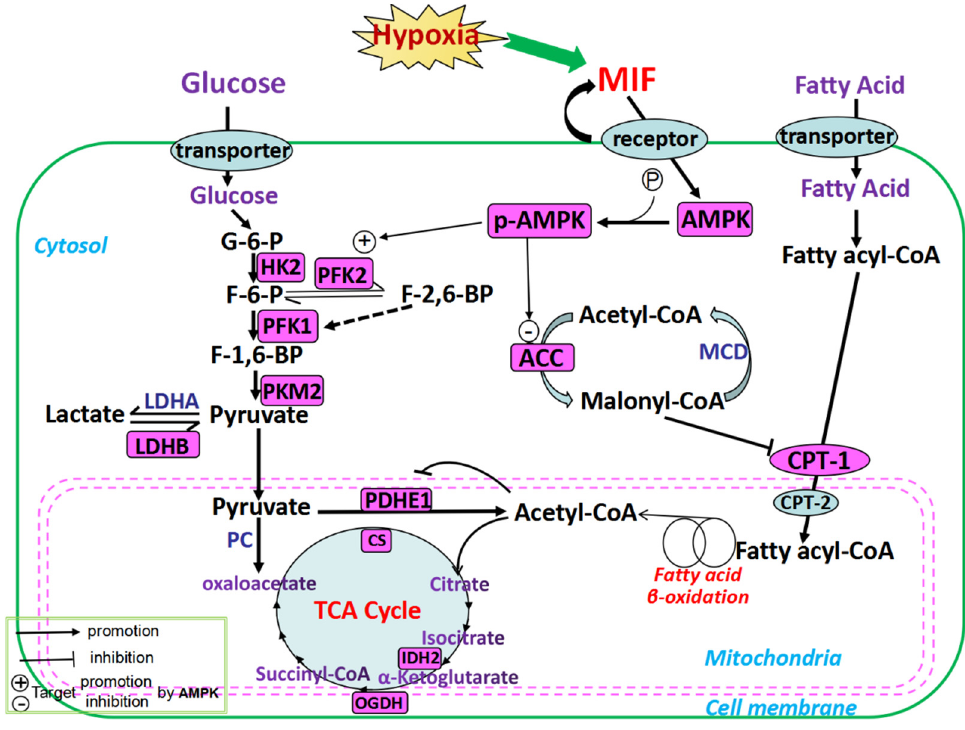
Figure 5. Schematic diagram of the mechanism of the key enzymes of myocardial energy metabo- lism.